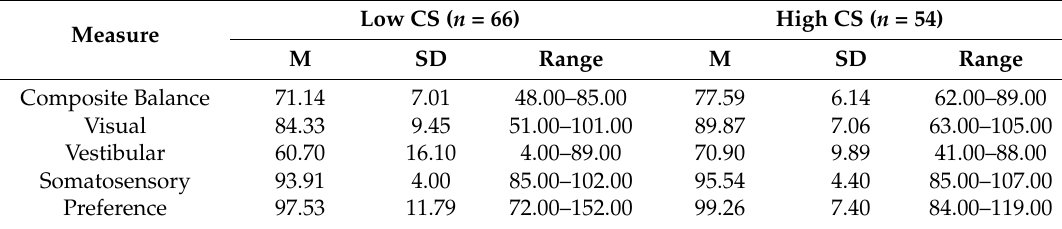
Table 4. Neurocom data descriptives compared with low and high chair stand